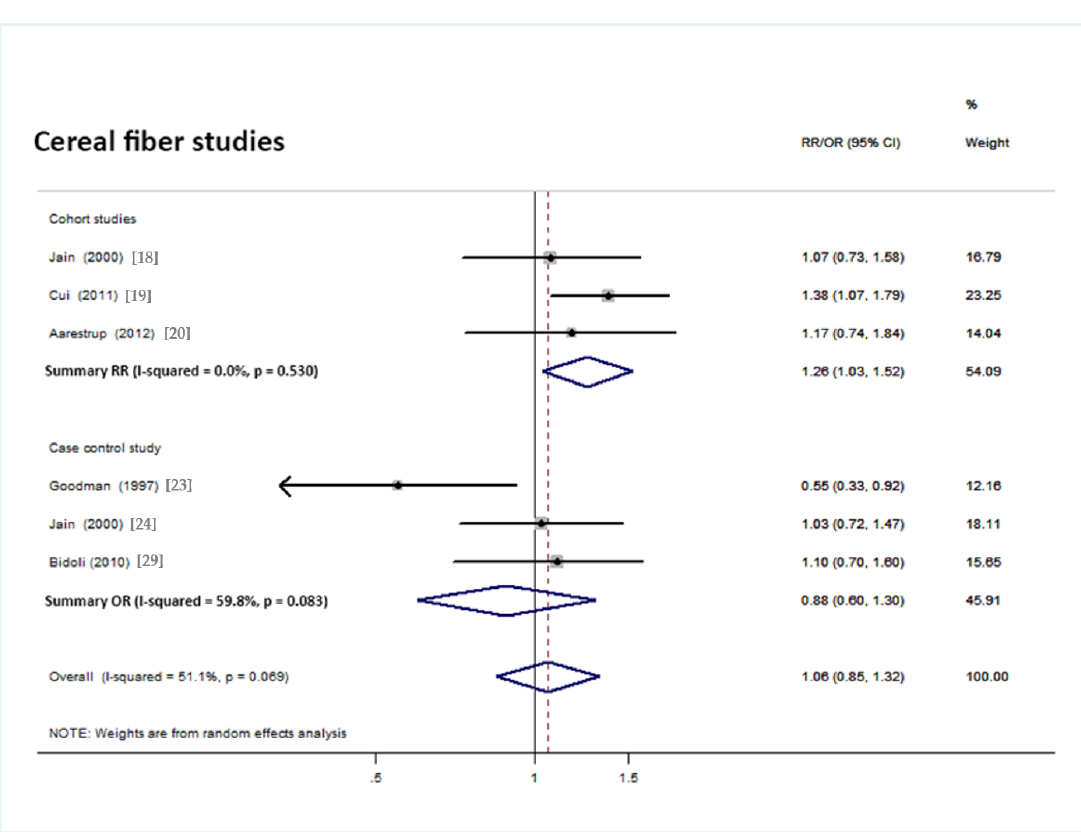
Figure 5. Forest plot of the summary risk estimate of endometrial cancer in the highest category of dietary cereal fiber intake compared with those in the lowest category.